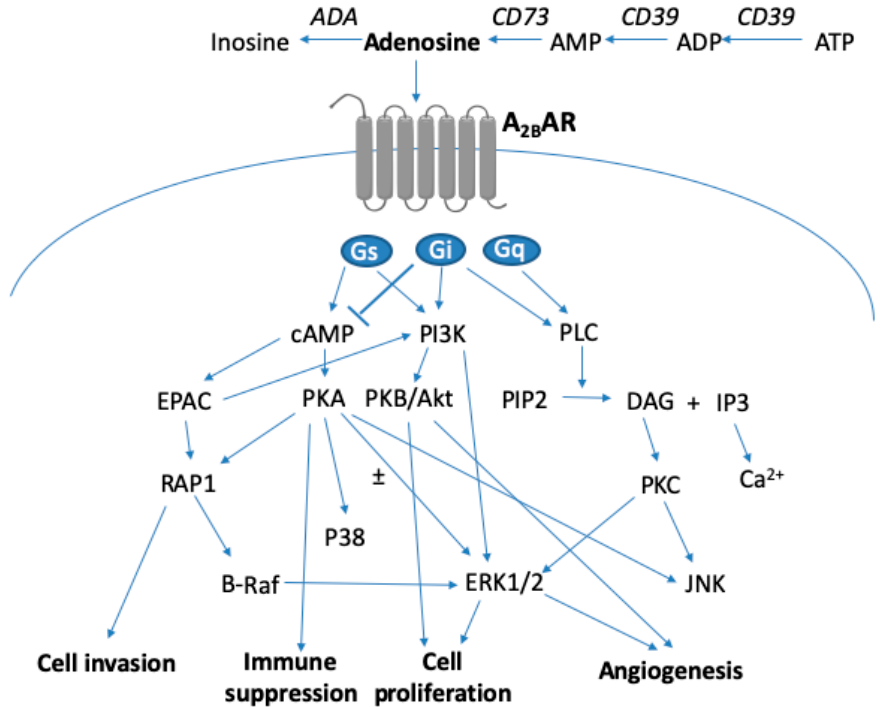
Figure 1. A 2B adenosine receptor (AR) signaling in mammalian cells and in the tumor microenvironment, as explained in the text. The three G proteins shown act through either G α , e.g., on cyclic AMP (cAMP), or G β , γ subunits, e.g., on phosphoinositide 3-kinase (PI3K). Protein kinase A (PKA) has either a stimulatory or inhibitory effect on extracellular signal-regulated kinase 1/2 (ERK1/2). For more detail see: [15,35,49,56,58]. For effects on specific immune cells, see [17,32].